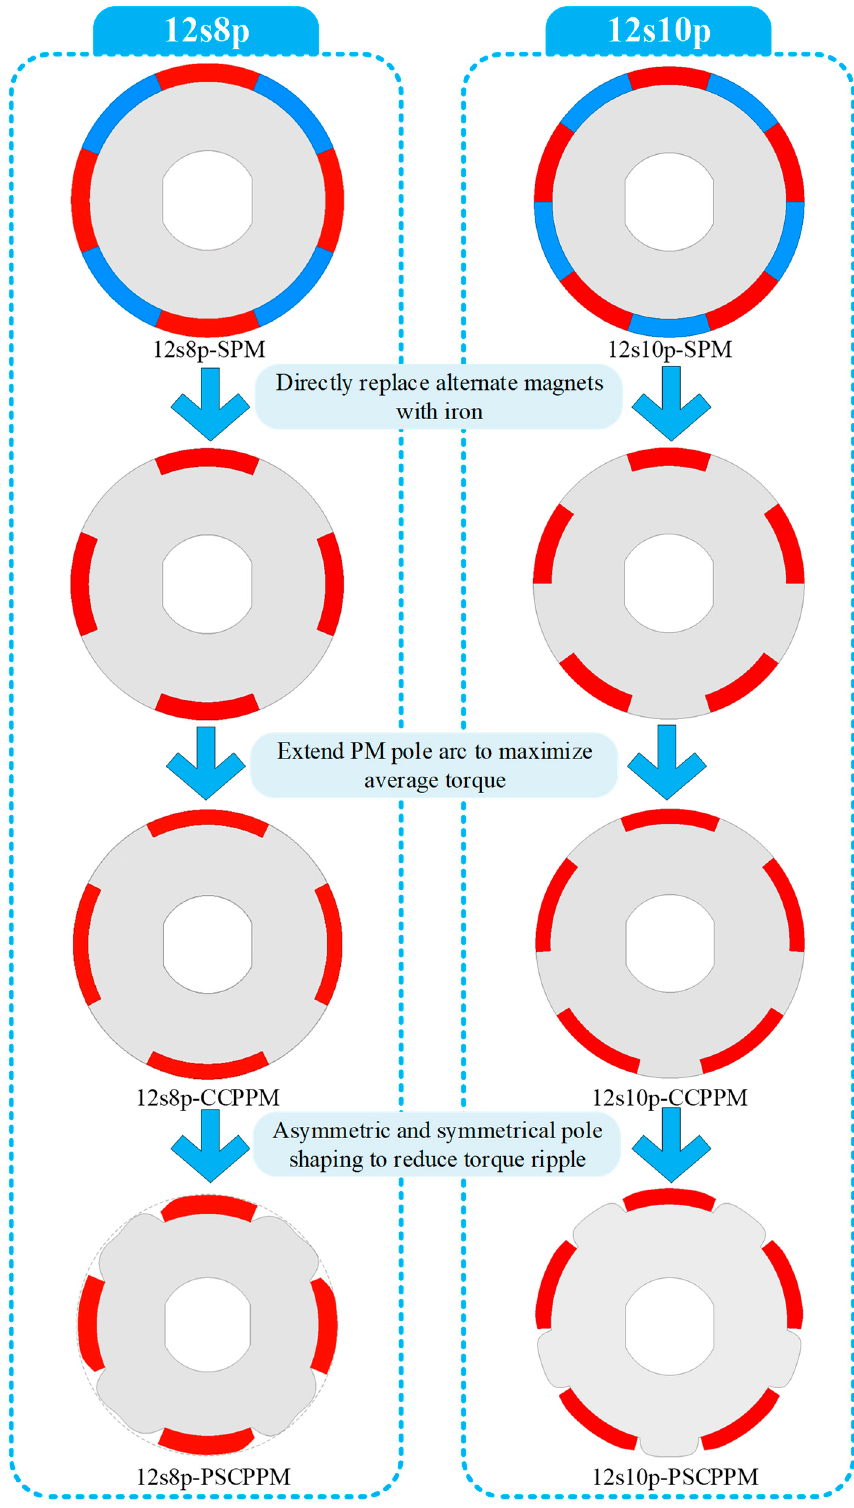
Figure 3. Models for analysis in this